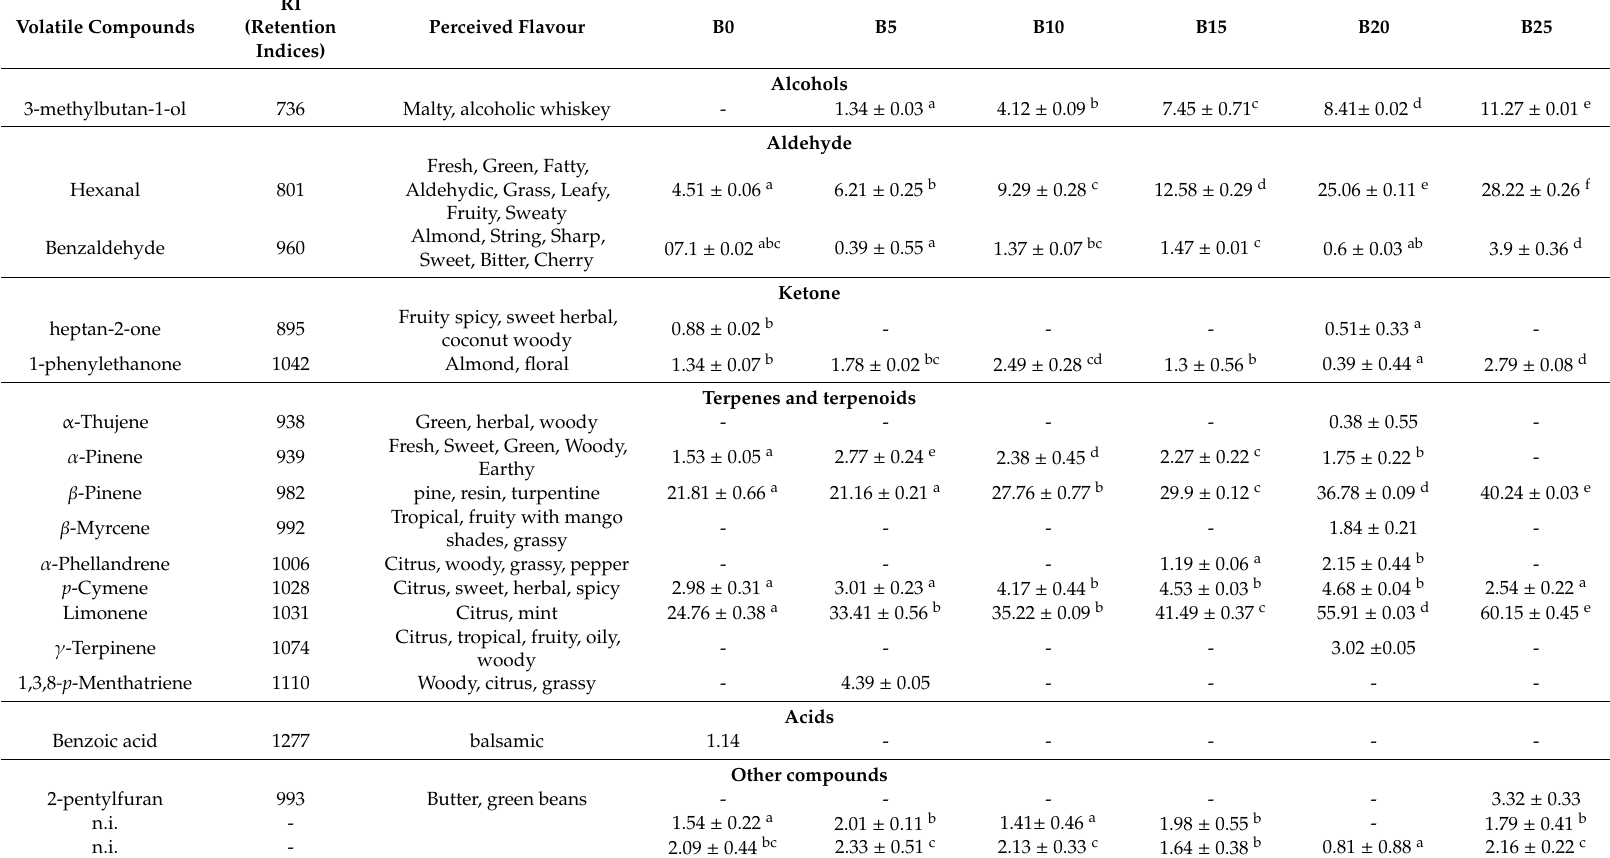
Table 5. Volatile compounds content of the enriched biscuits with spent malt